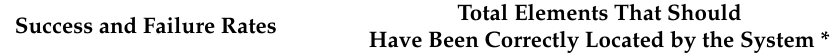
Table 1. Results provided by the system for all beef tomato images.